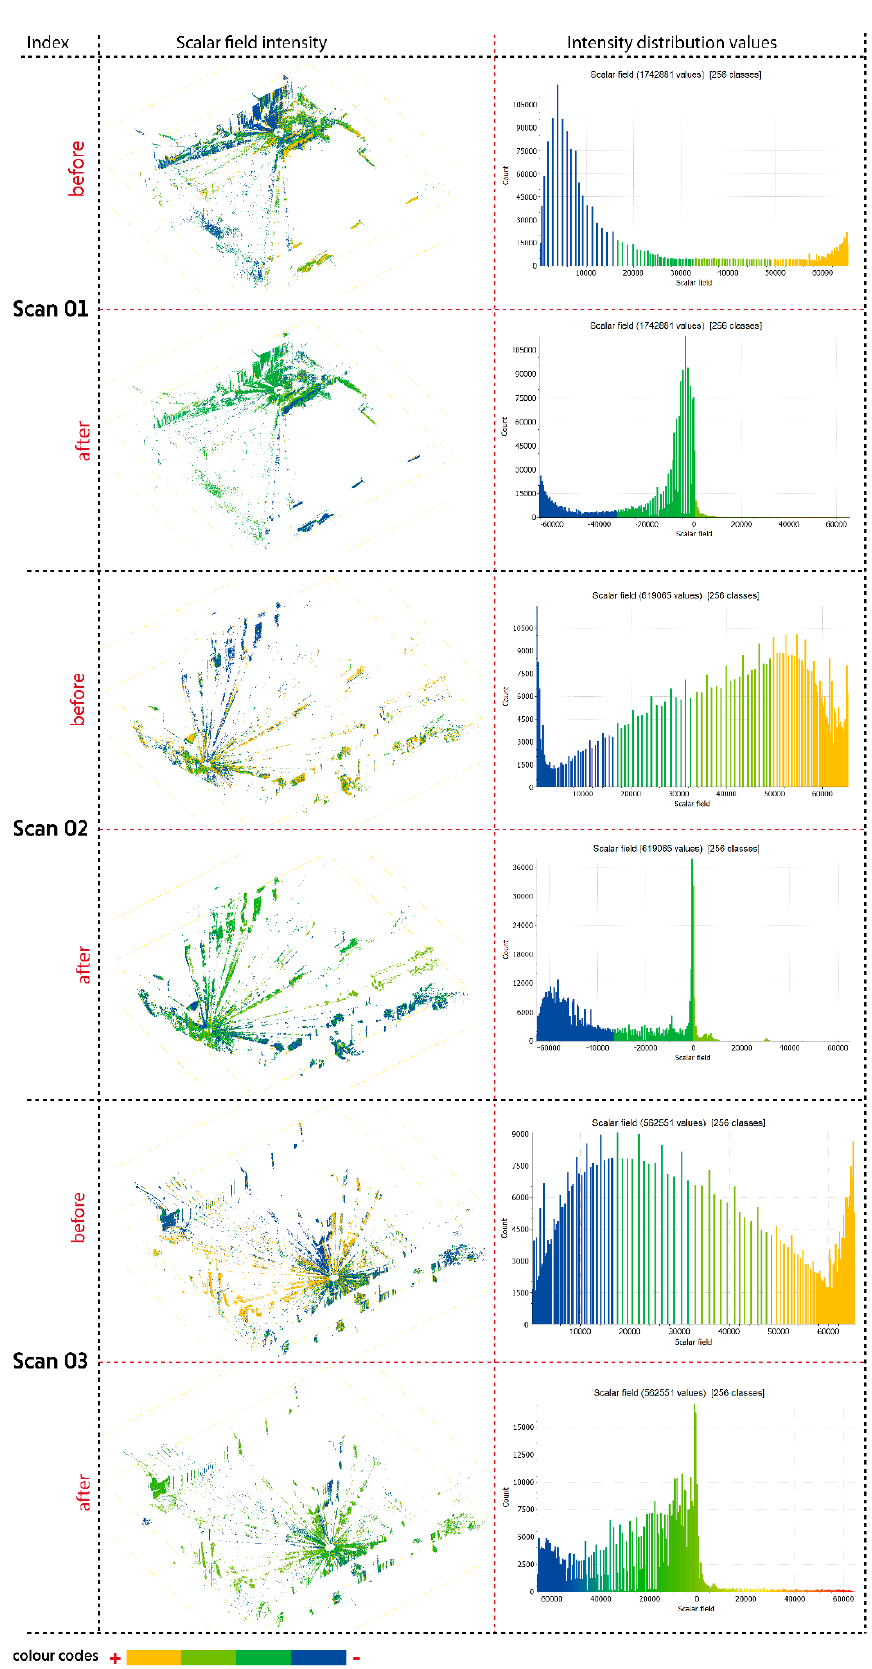
Figure 10. Intensity correction on each data scan.